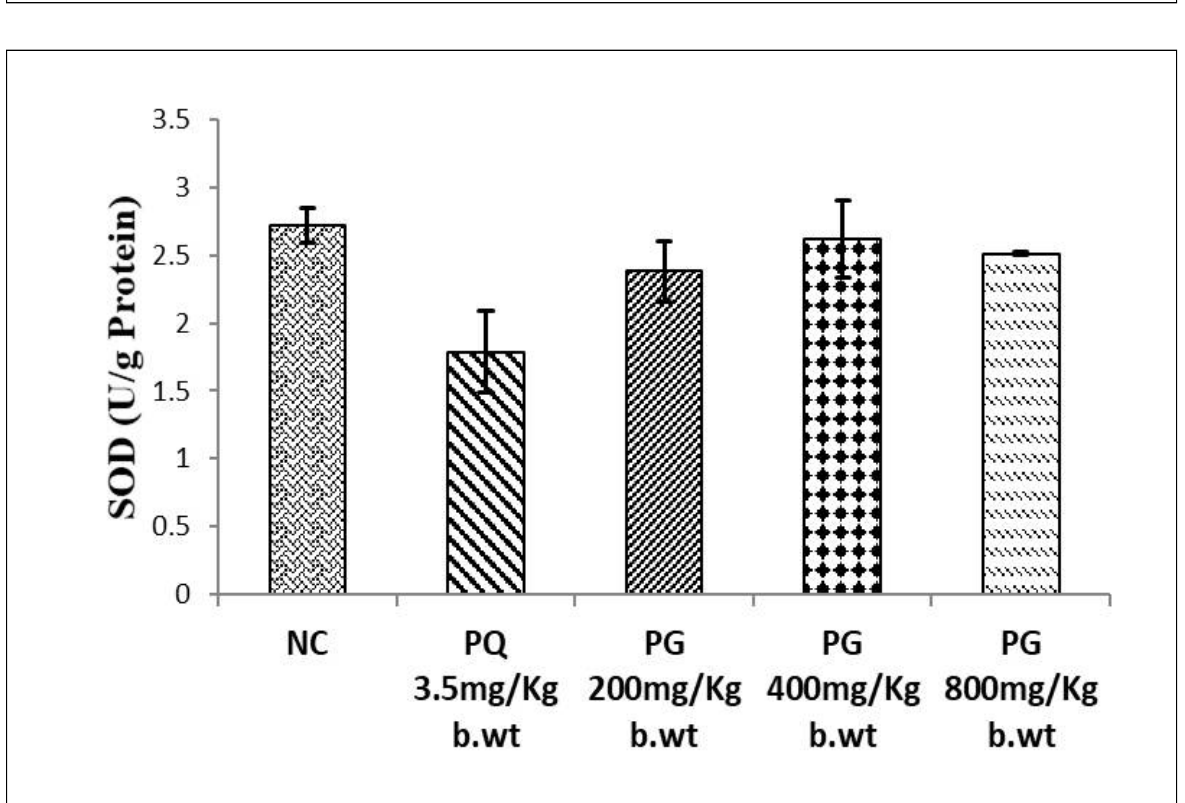
Figure 7: Effect of Psidium guajava leaf extract administration on serum superoxide dismutase activity of male Wistar albino rats administered 3.5 mg/kg b.wt.